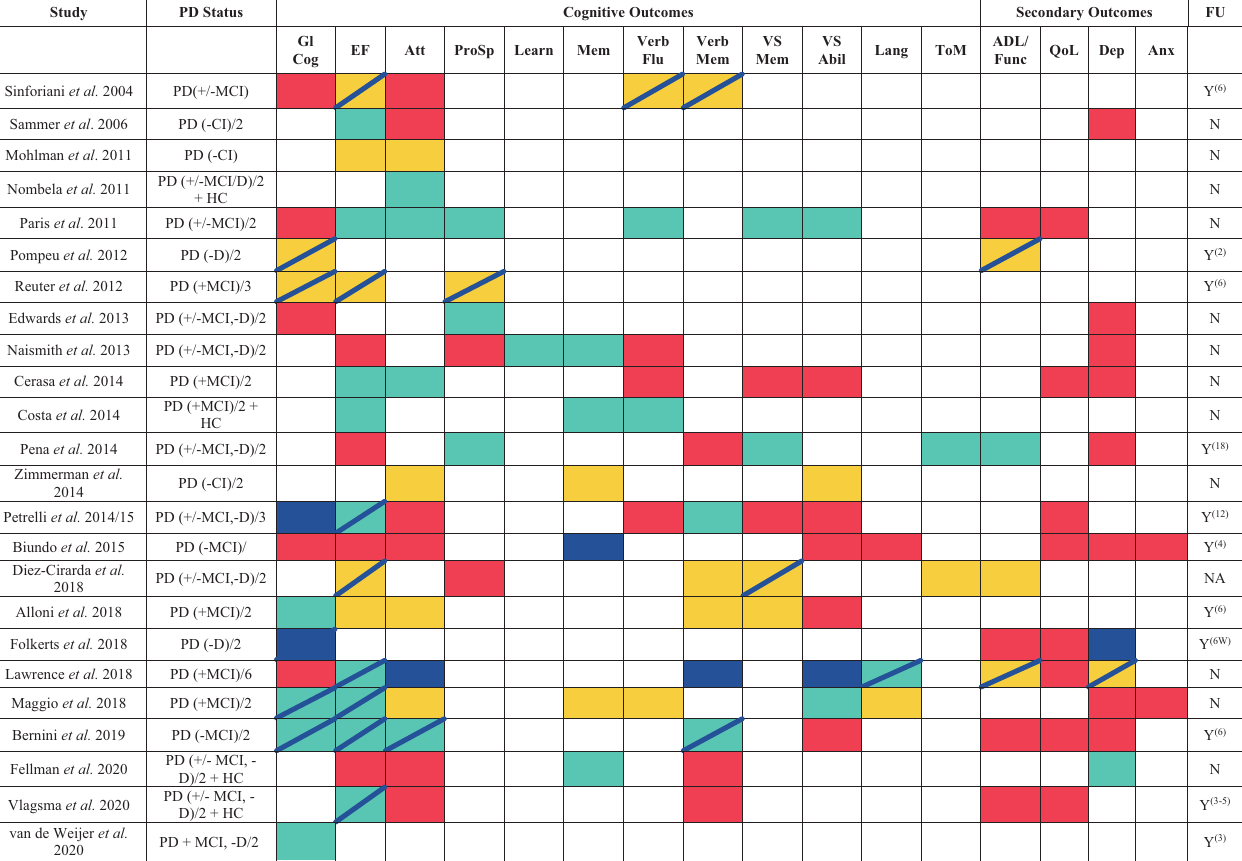
TABLE 2 | Summary of Cognitive training in Parkinson’s disease study outcomes.